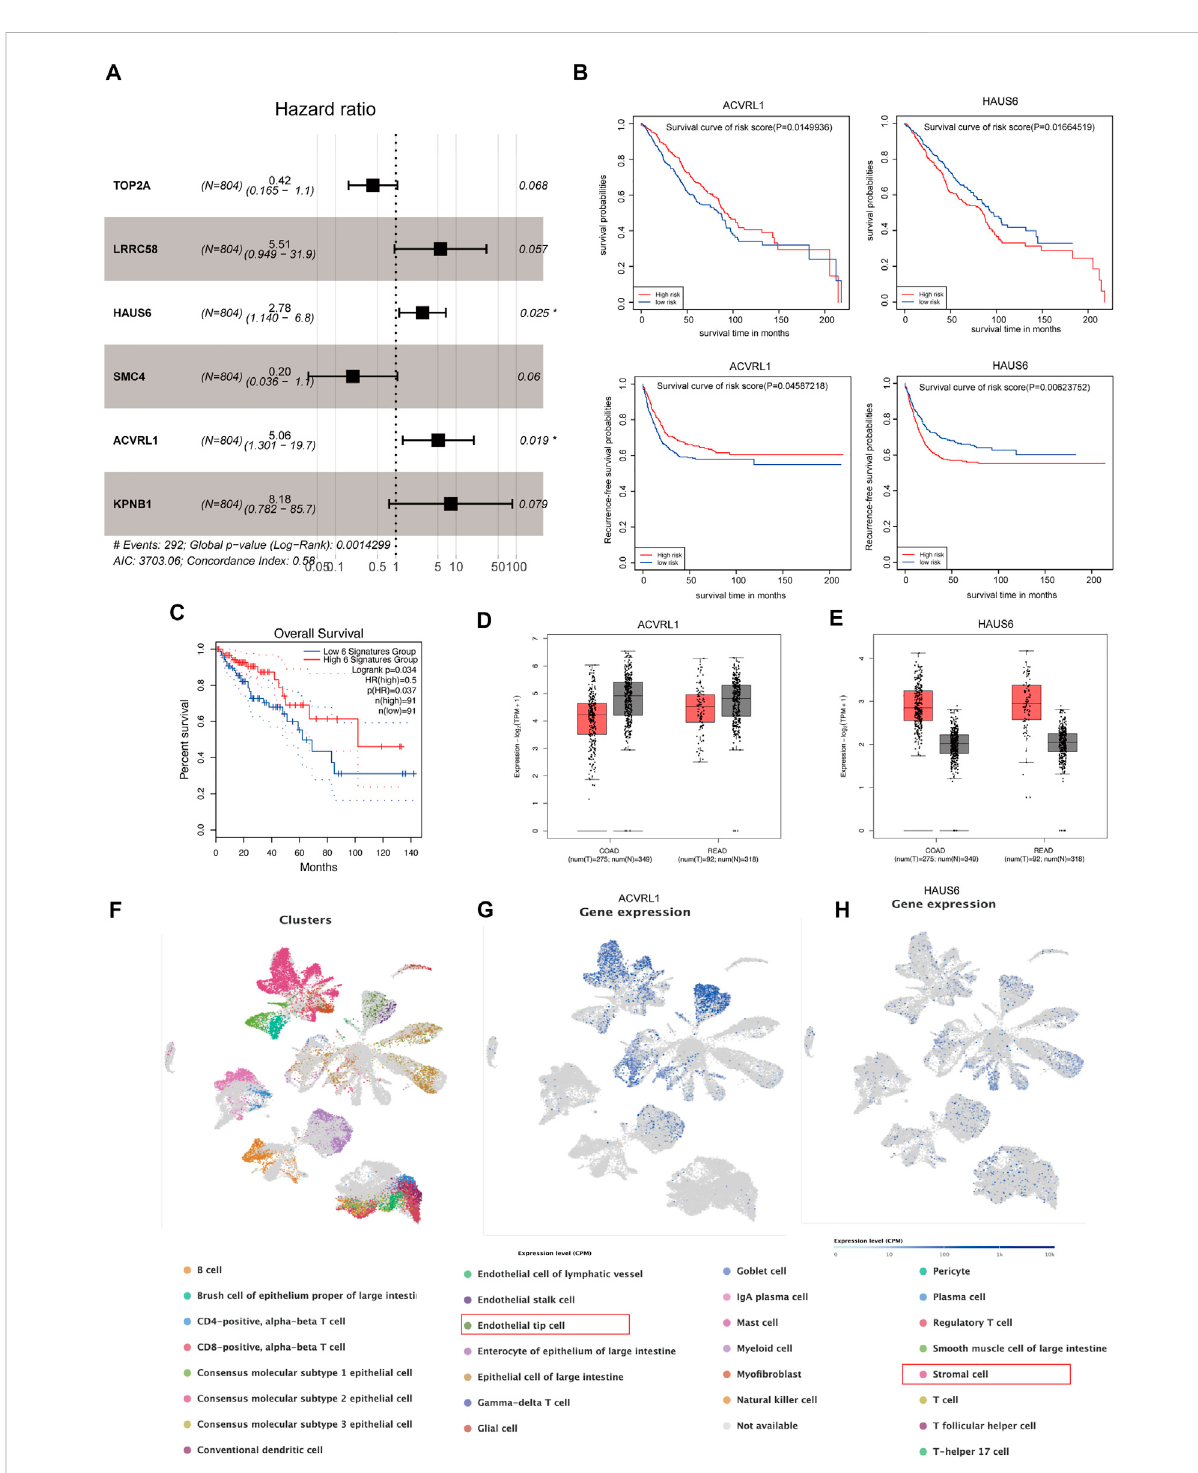
FIGURE 6 Identi fi cation of key genes modi fi ed by m6A. (A) Multivariable Cox regression analyses in the meta-GEO cohort by using the RFS model. (B) Survivalplotofthesigni fi cantgenesobtainedbymultivariableCoxregression,includingACVRL1andHAUS6. (C) Overallsurvivalofthesignaturewas obtained by multivariableCox regression from themeta-GEOcohort intheTCGA cohort. (D,E) GeneexpressionofACVRL1 and HAUS6 in theTCGA cohort. (F) Thirty Q21 clusters of the single-cell RNA-seq analysis. (G,H) Distribution of ACVRL1 and HAUS6 in colorectal cancer